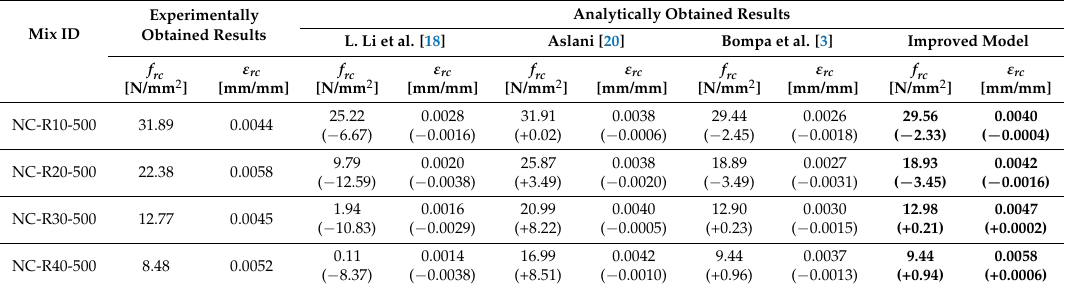
Table 6. Comparison of experimentally and analytically obtained results of peak stress f rc and strain ε rc of rubberized